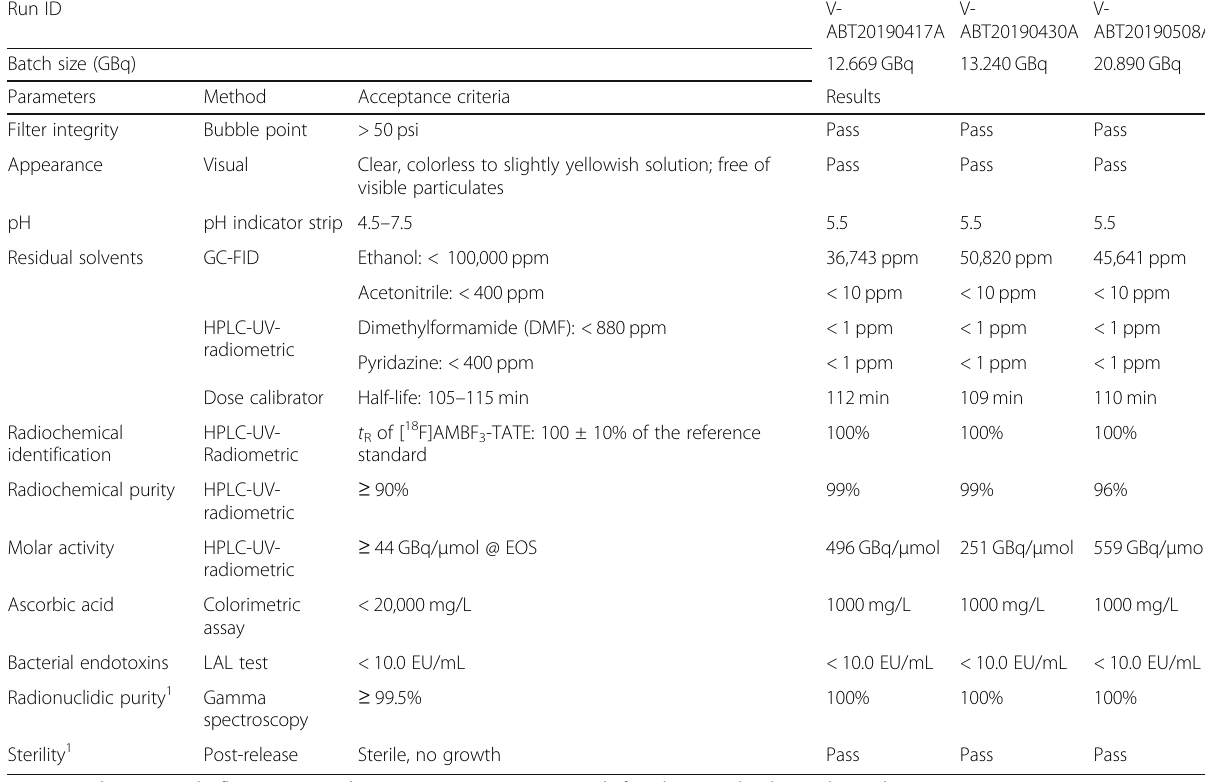
Table 3 Quality control (QC) of [ 18 F]AmBF 3 -TATE injection solution from three individual validation runs